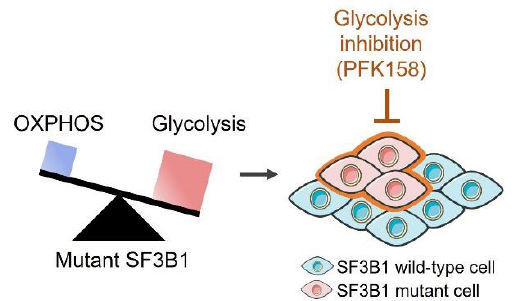
Figure 6. Thematic model of the glycolysis dependency in SF3B1 -mutated cells.